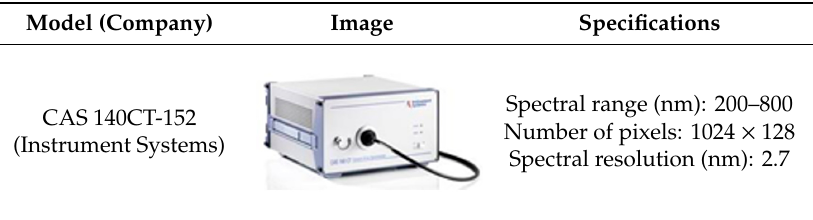
Table 1. Specifications of spectrometer (CAS